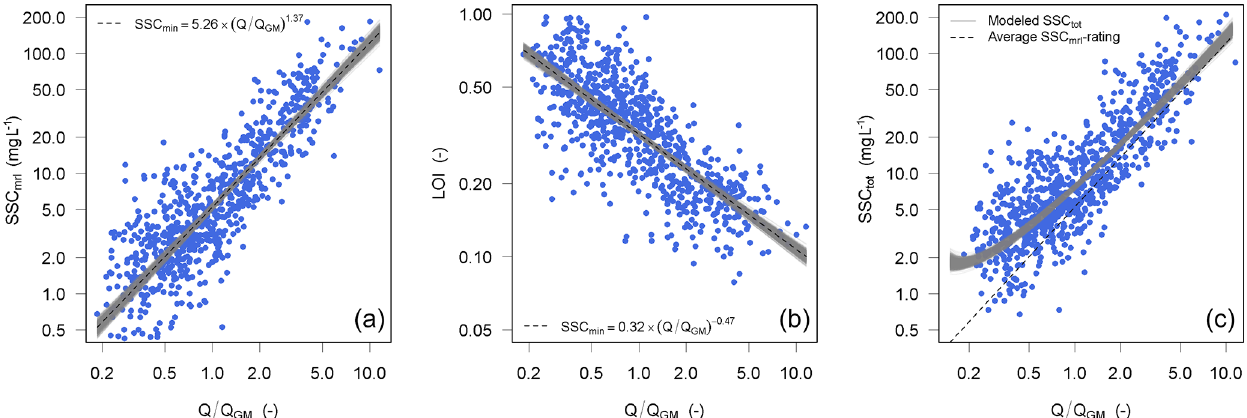
Figure 10. Statistical modeling of the total suspended sediment concentration (SSC tot , c ) based on the positive and negative power-law rating of the mineral fraction of SSC (SC mrl , a ) and the loss on ignition (LOI, b ), respectively.